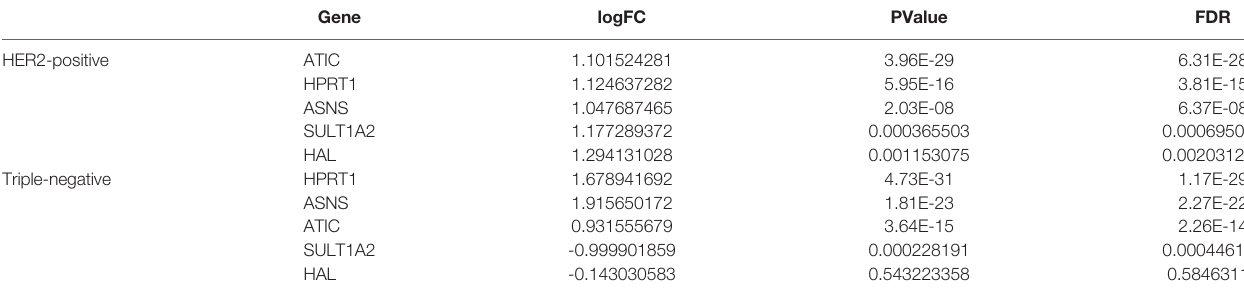
TABLE 2 | Results of differential expression analysis of fi ve metabolism-related genes. Gene